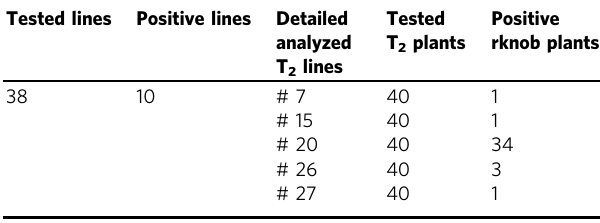
Table 1 List of induced inversions detected in the T 2 generation as determined by PCR-based